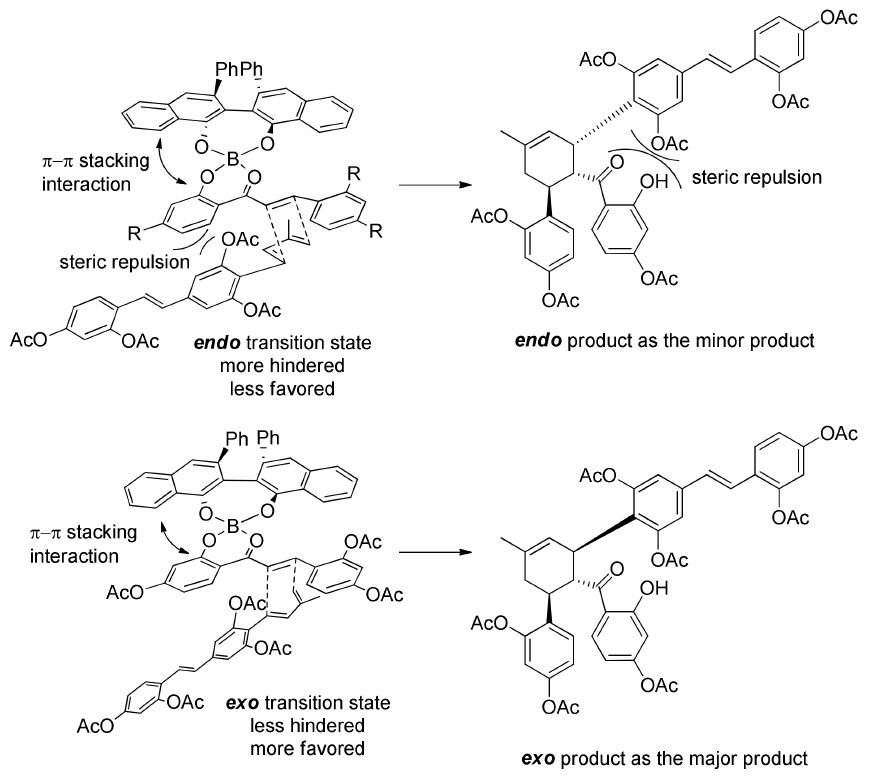
Figure 60. Transition states occurring during Diels–Alder cycloaddition between dienophile 172 and diene 173 , explaining the peculiar exo